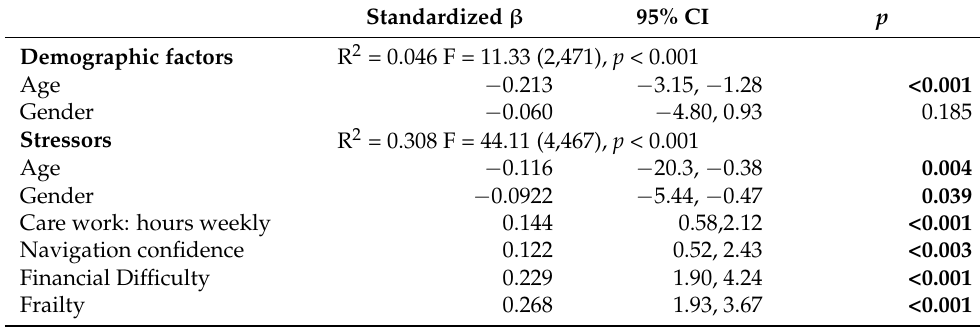
Table 2. Hierarchical Linear Regressions Results of Caregiver Factors with Caregivers’